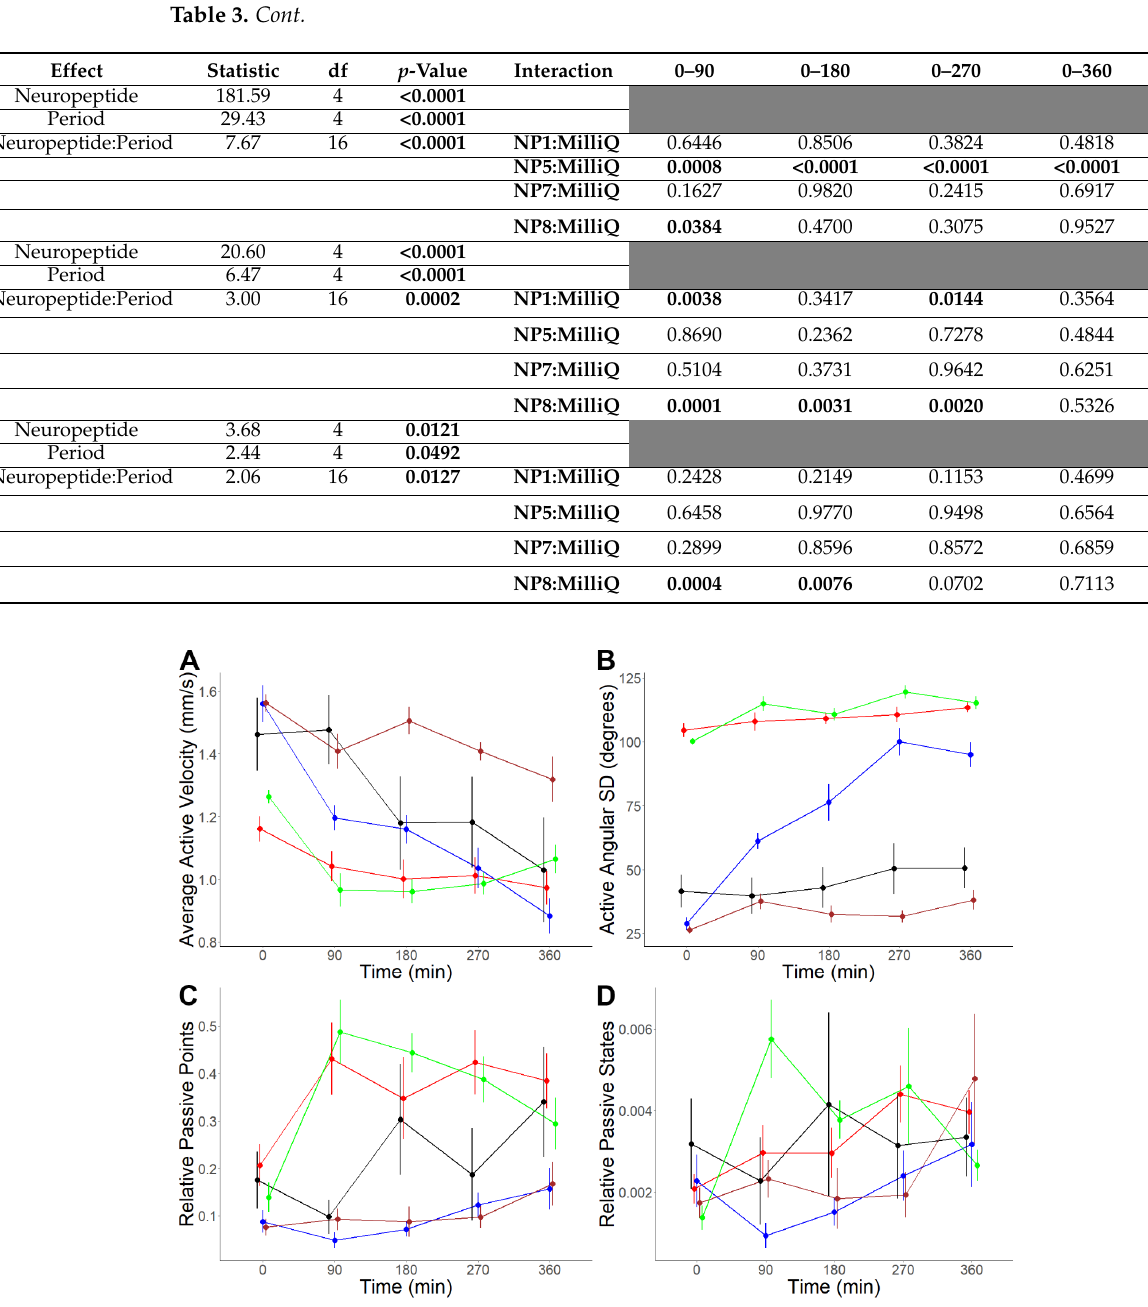
Figure 5. Changes in S. mansoni cercariae behaviour pre-exposure and 90 min, 180 min, 270 min, and 360 min post-exposure to MilliQ water and 3 mg/mL NP1, NP5, NP7 and NP8 (final concentra- tion: 59 µg/mL). ( A ) Average active velocity (mm/s); ( B ) active angular SD (degrees); ( C ) relative passive points; ( D ) relative passive states. A two-way ANOVA test was used to calculate p -values for the mixed-effects interaction of pre-exposure and at different durations post-exposure to puta- tive neuropeptide treatments against MilliQ water. Statistical analysis and figure configuration were both performed using R Studio. Colour: black: MilliQ; red: NP1; blue: NP5; brown: NP7; green: NP8. Table 3. Two-way ART ANOVA results, comparing the effects of S. mansoni cercarial exposure to NP1, NP5, NP7, and NP8 at 3 mg/mL to MilliQ water pre-exposure and at 90 min intervals over 360 min post-exposure (final concentration: 59 µg/mL). Test statistics, degrees of freedom, and p -values for the main effects of putative neuropeptide and period (pre-exposure vs. 90 min, 180 min, 270 min, and 360 min post-exposure), and their interaction. If the interaction effect was significant, pairwise In contrast to NP1 and NP8, prolonged exposure to NP5 produced similar effects contrasts testing analysed the significance of the change in behaviour pre- vs. post-exposure be- tween MilliQ and each of the putative neuropeptides. Metrics: active velocity, active angular SD, relative number of passive points and states. Significant data ( p -value < 0.05) is in bold.